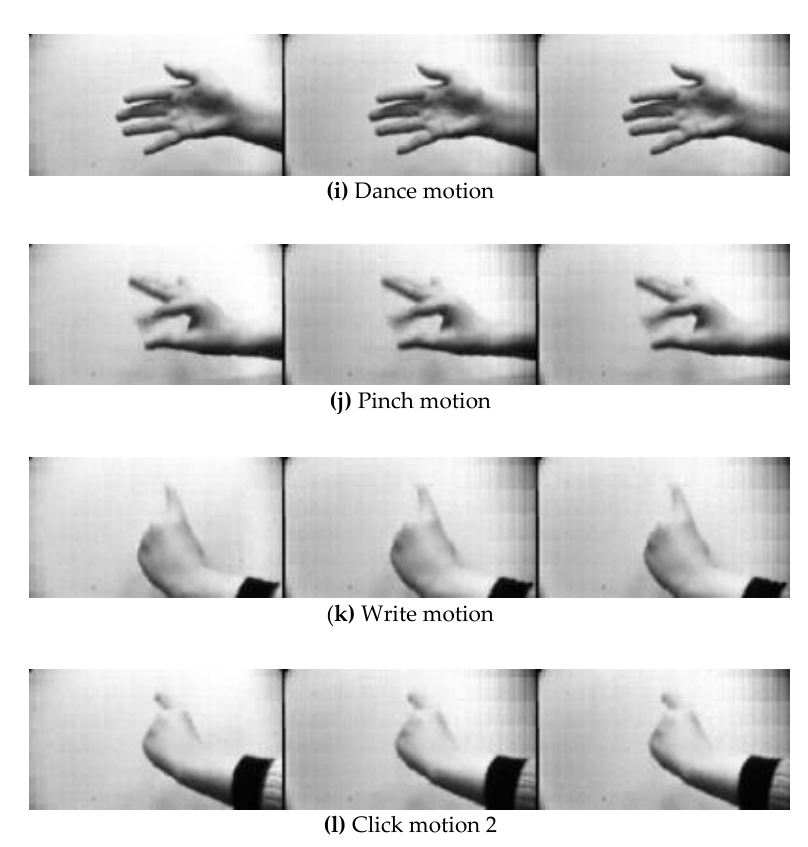
Figure 7. Post-extraction for first subject’s 3D hand micro motions (LCR).